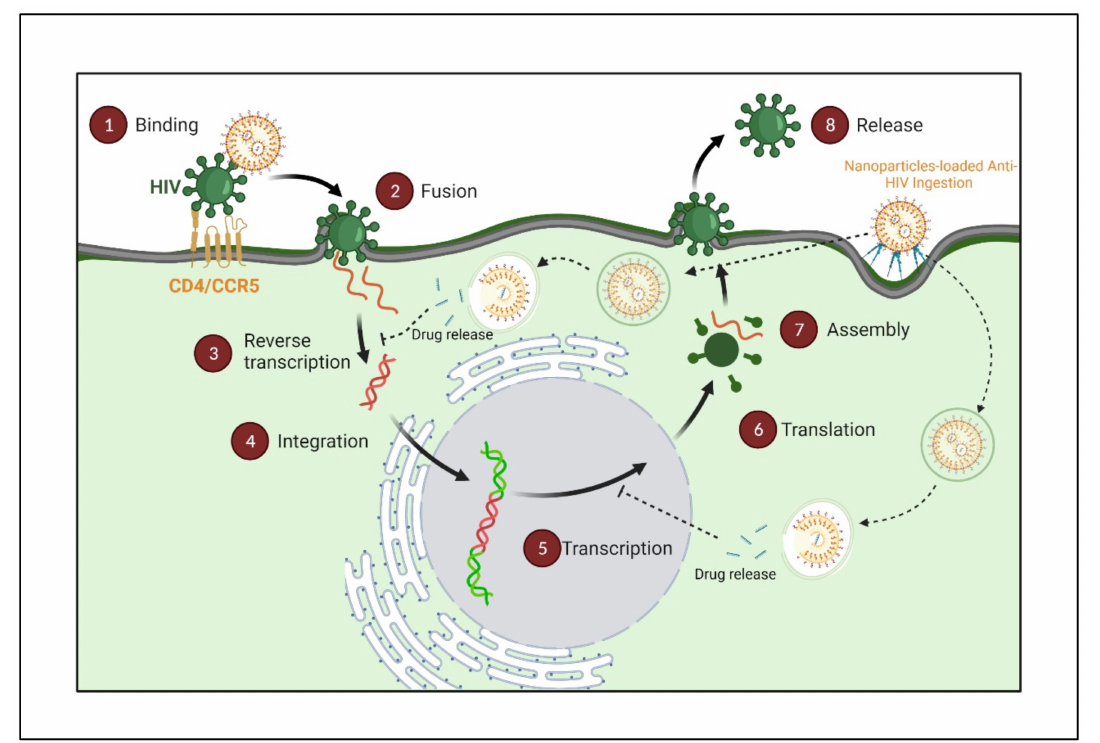
Figure 5. HIV sites for therapeutic intervention using nanopharmaceuticals. (Created with Bioren- der.com (access on 19 June 2022)).